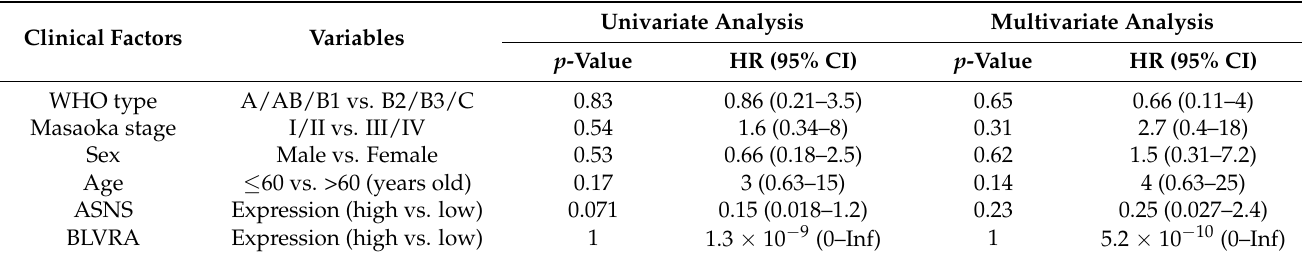
Table 1. Univariate and multivariate analyses of the correlation of clinical variables and expression of metabolic genes with overall survival in